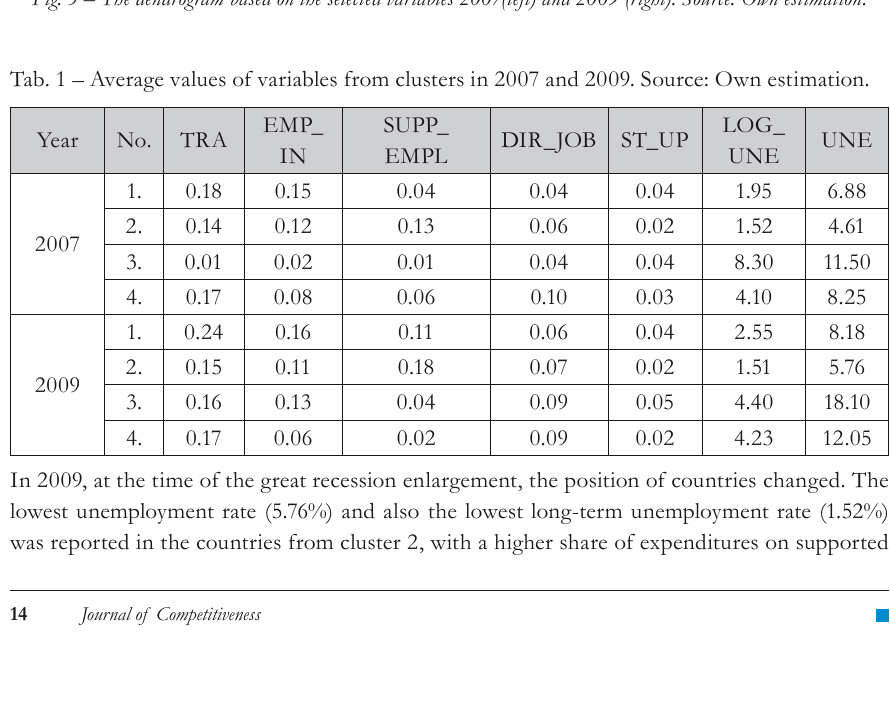
Fig. 5 – The dendrogram based on the selected variables 2007(left) and 2009 (right). Source: Own estimation.